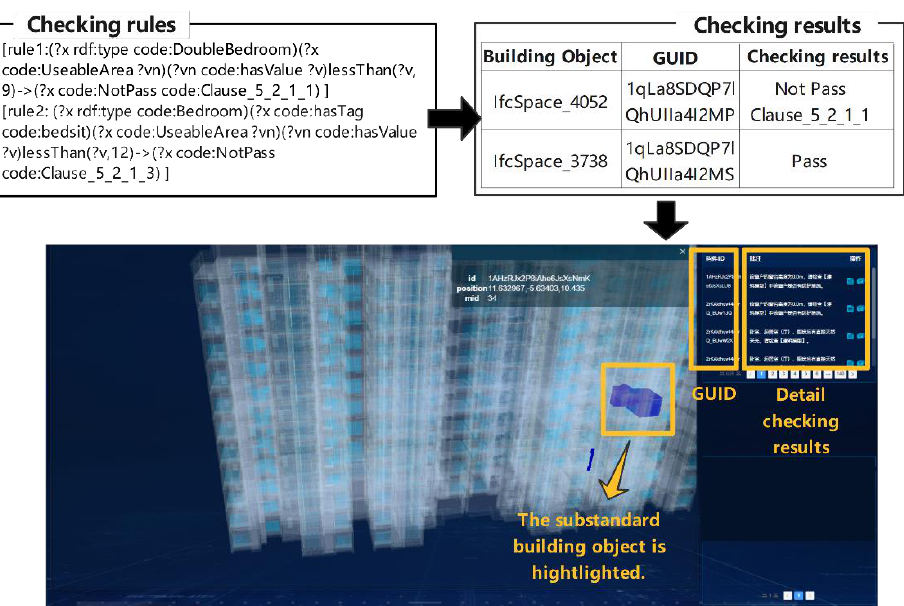
Figure 23. Checking the results of the designed building model (partly).